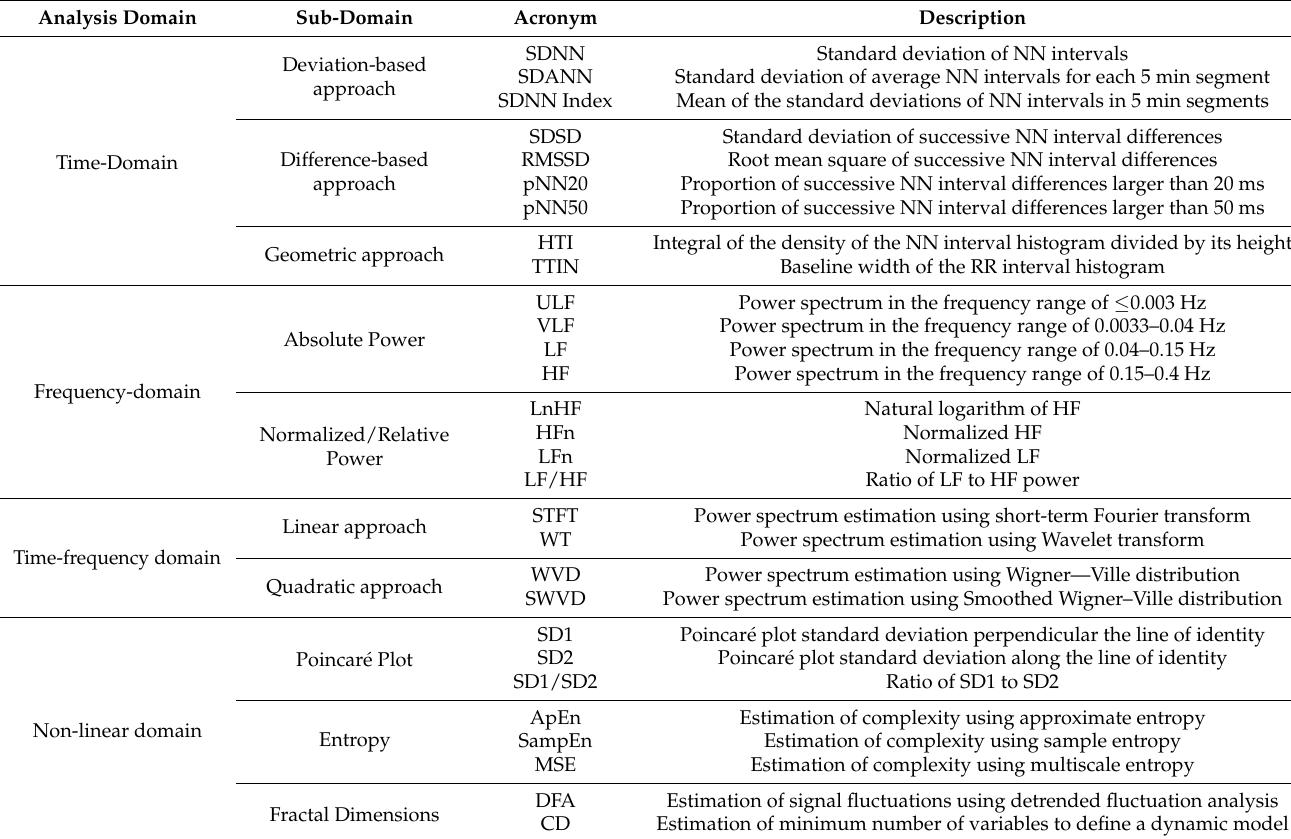
Table 1. A summary of HRV indices according to their respective analysis